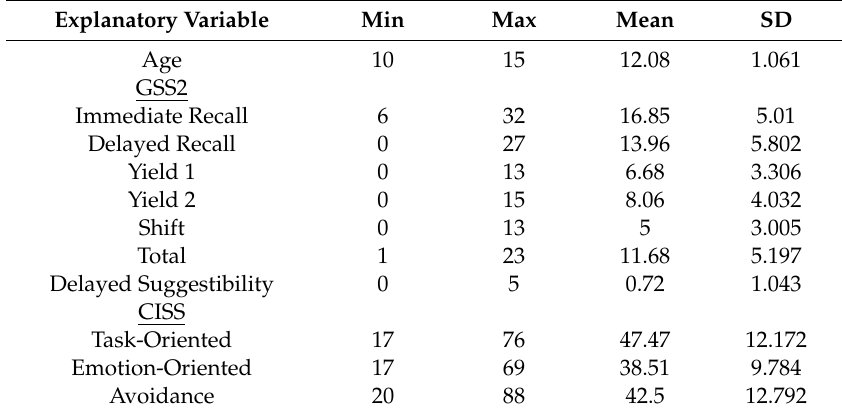
Table 1. Average Age and Scores for the GSS 2 and CISS ( n =